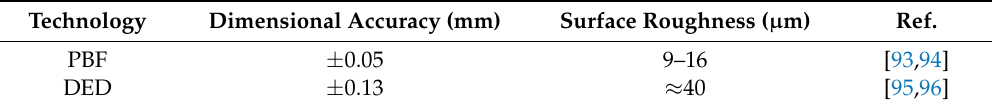
Table 1. Comparison between PBF and DED